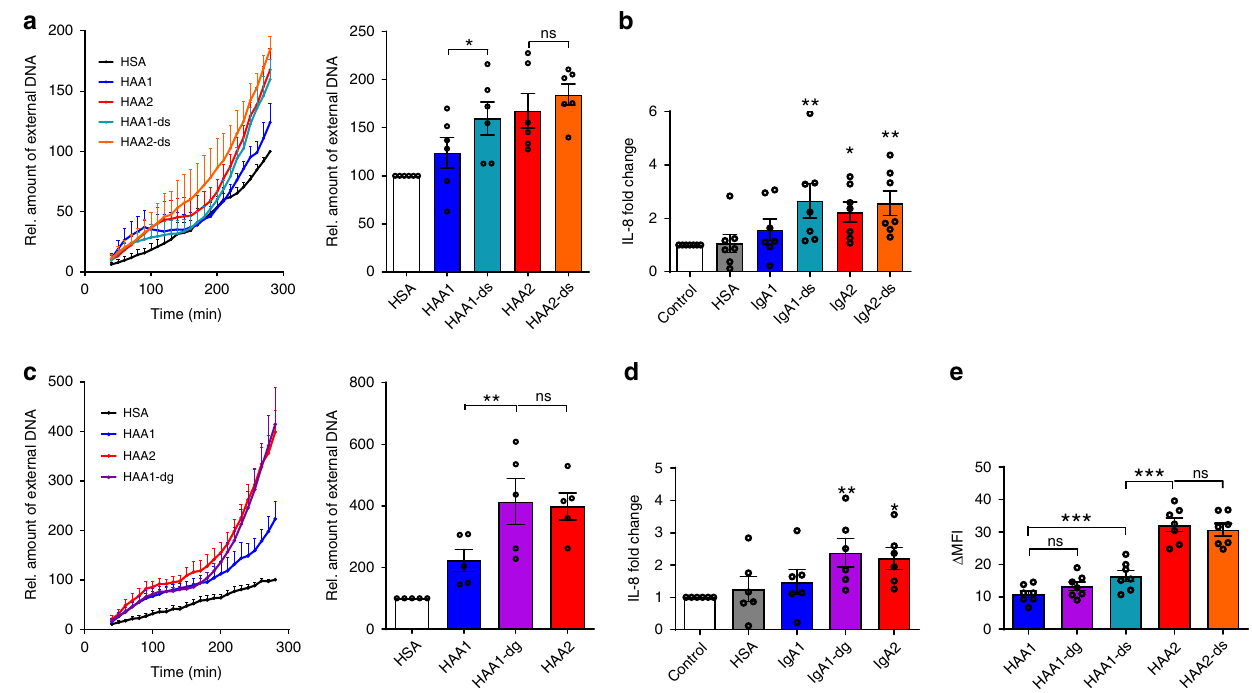
Fig. 4 Removal of sialic acid or all N -glycans increases pro-in fl ammatory activity of IgA1. a Human neutrophils were stimulated with 100 µ g/ml of human serum albumin ( = HSA) and native or desialylated ( = -ds) heat aggregated IgA1 and IgA2 ( = HAA1 and HAA2). NET formation was evaluated by staining extracellular DNA with Sytox Green. Shown is NET formation over time and the relative amount of extracellular DNA at 280min after stimulation normalized on HSA treatment; n = 6 donors. b IL-8 released by macrophages 6 h after seeding in wells coated with HSA, IgA1, desialylated IgA1 ( = IgA1-ds), IgA2 or desialylated IgA2 ( = IgA2-ds); n = 7 donors. c Human neutrophils were stimulated with 100 µ g/ml of human serum albumin ( = HSA) and native or deglycosylated ( = -dg) heat aggregated IgA1 and IgA2 ( = HAA1 and HAA2); n = 5 donors. d IL-8 released by macrophages 6 h after seeding in wells coated with HSA, IgA1, deglycosylated IgA1 ( = IgA1-dg) or IgA2; n = 6 donors. e Binding of heat aggregated IgA1 and IgA2 ( = HAA1 and HAA2) that has been desialylated ( = -ds) or deglycosylated ( = -dg) on neutrophils measured by fl ow cytometry; n = 7 donors. Signi fi cances were tested with paired one-way ANOVA followed by Bonferroni correction for selected pairs of columns a , c , e or Dunnet ’ s correction b , d . * p < 0,05; ** p < 0,01; and *** p < 0,001. Data are presented as mean ± s.e.m. a , c or scatter blots with bars showing mean ± s.e.m. a – e . Source data are provided as a Source Data fi